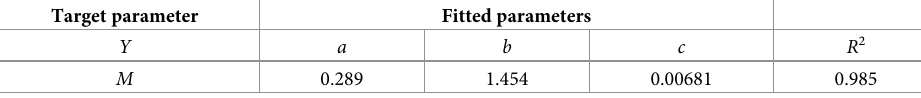
Table 2. Fitted softening modulus of